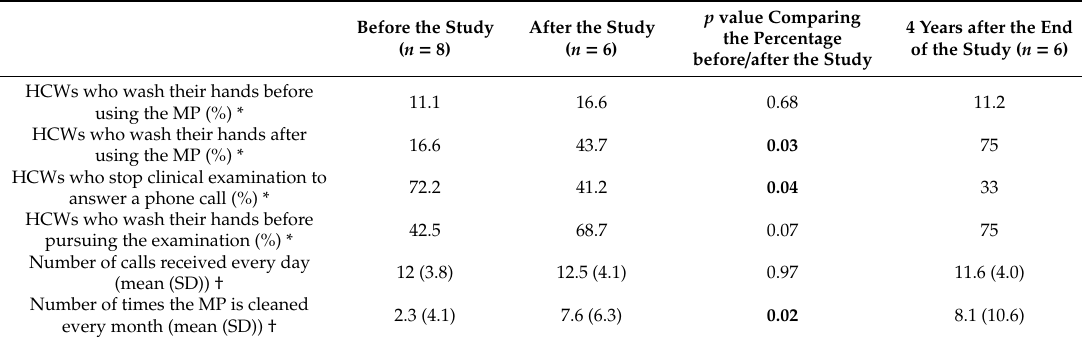
Table 2. Hygiene behaviours of the 8 healthcare workers (HCWs) who participated to the study. HCWs who wash their hands before using the MP (%) *